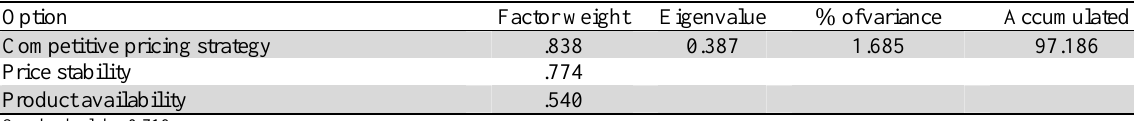
The summary of factors associated with pricing effects